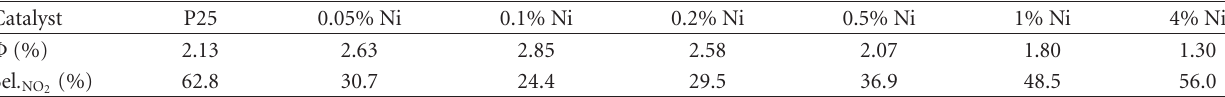
Table 1: The apparent quantum yields and selectivities of NO 2 of various catalysts: catalyst loading: 0.2 g, intensity of irradiation: 1mW/cm 2 ,